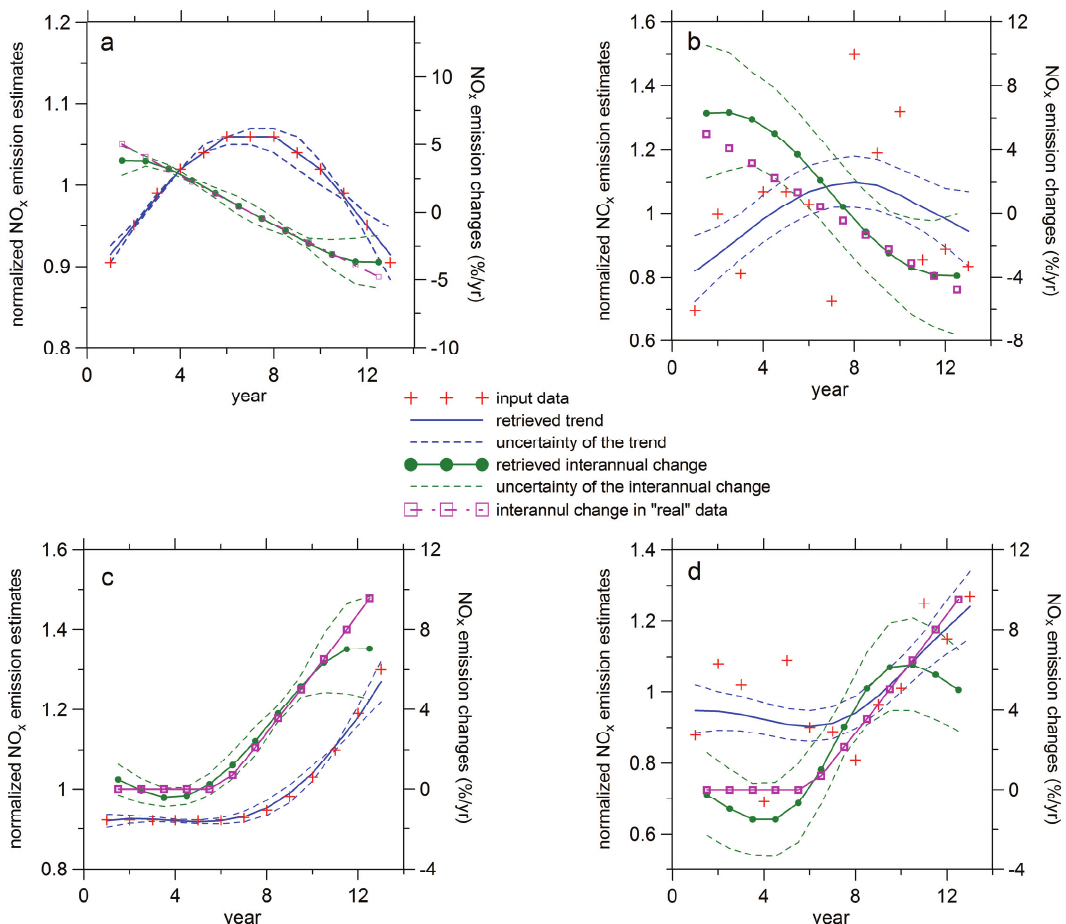
Fig. 6. Examples of application of the nonlinear trend estimation algorithm to artificial time series: (a, c) the “ideal” cases where the input data are determined by smooth nonlinear functions and (b, d) cases where the input data are determined by the same nonlinear functions but with added random perturbations. The results are obtained with two neurons in the network ( N =2). The uncertainties are evaluated in terms of the 68.3 percentile.